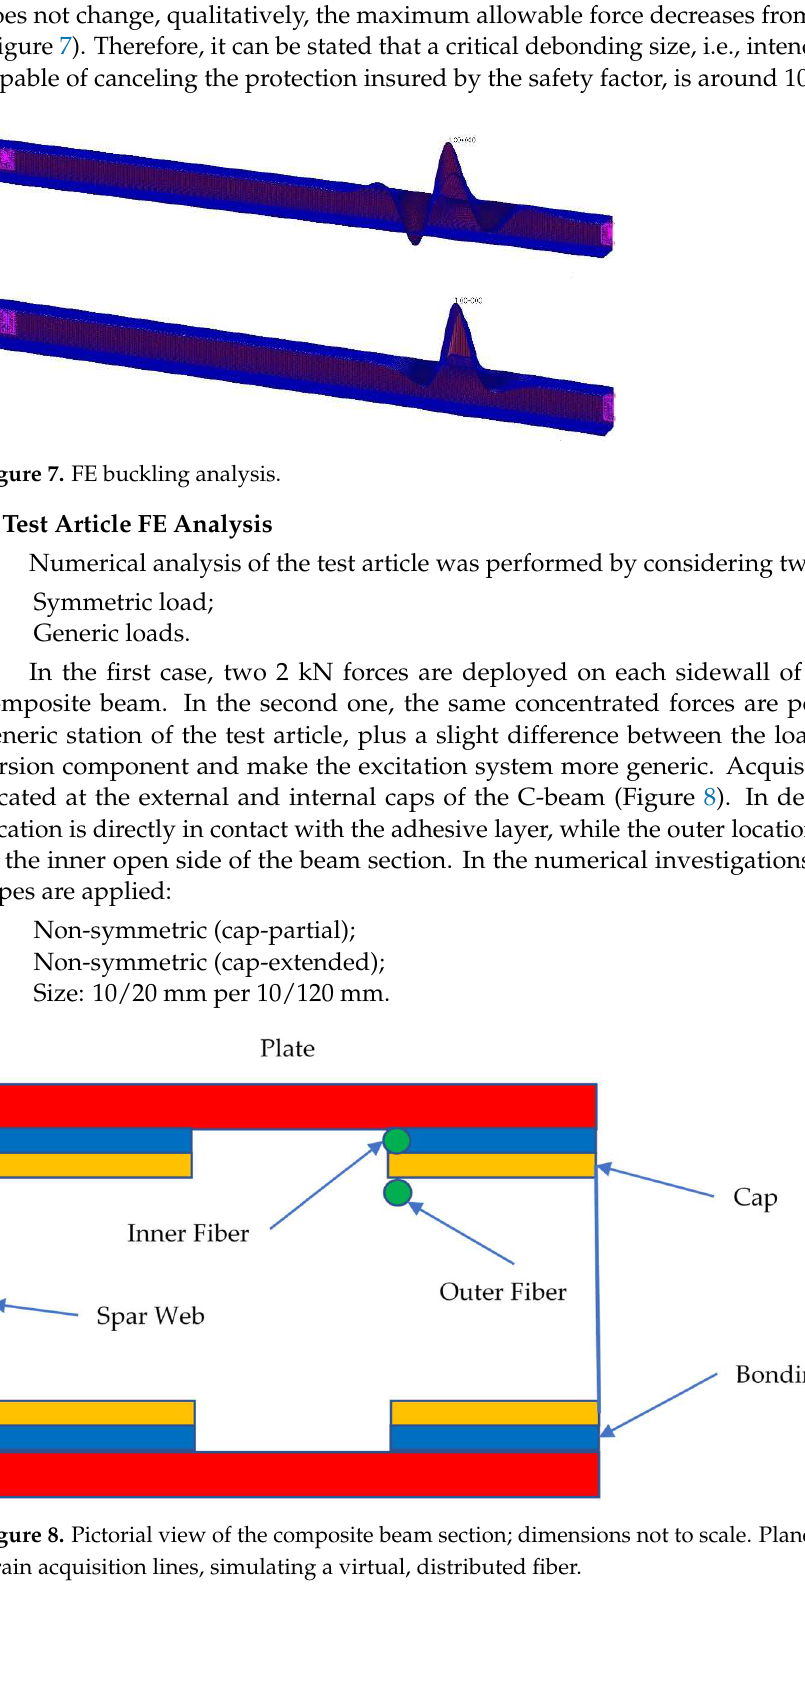
Figure 6. FE representation of the test article design [36].